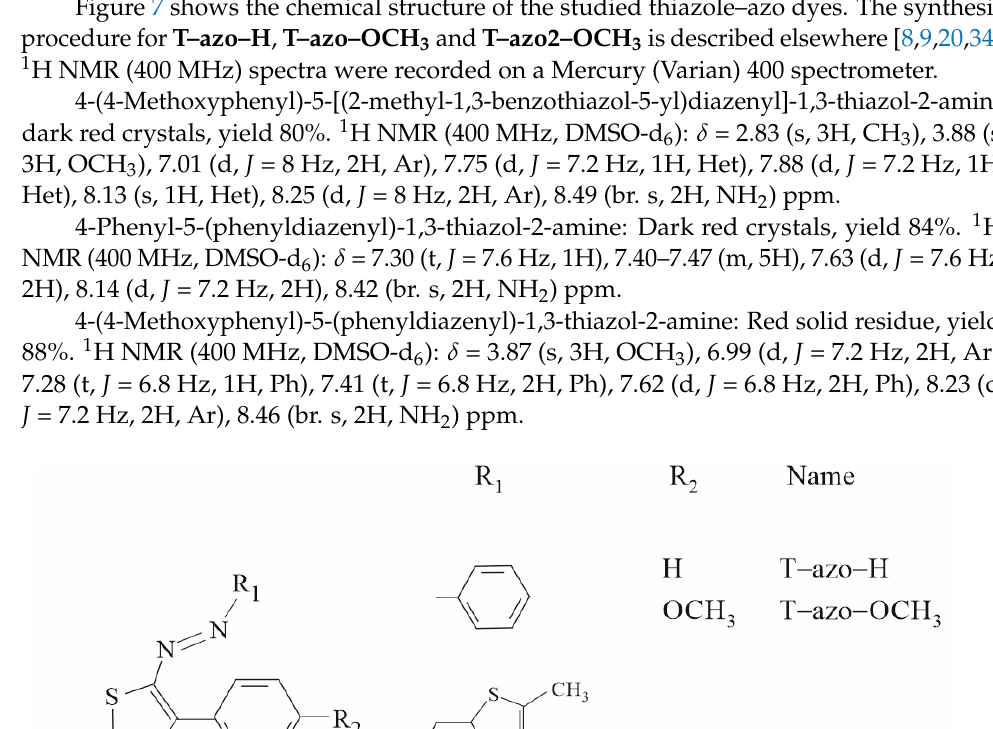
Figure 8. Photoinduced birefringence experimental setup at 532 nm: P—polarizer; A—analyzer; PhD—photodetectors; M—mirror; S—sample; MS—mechanical shutters.